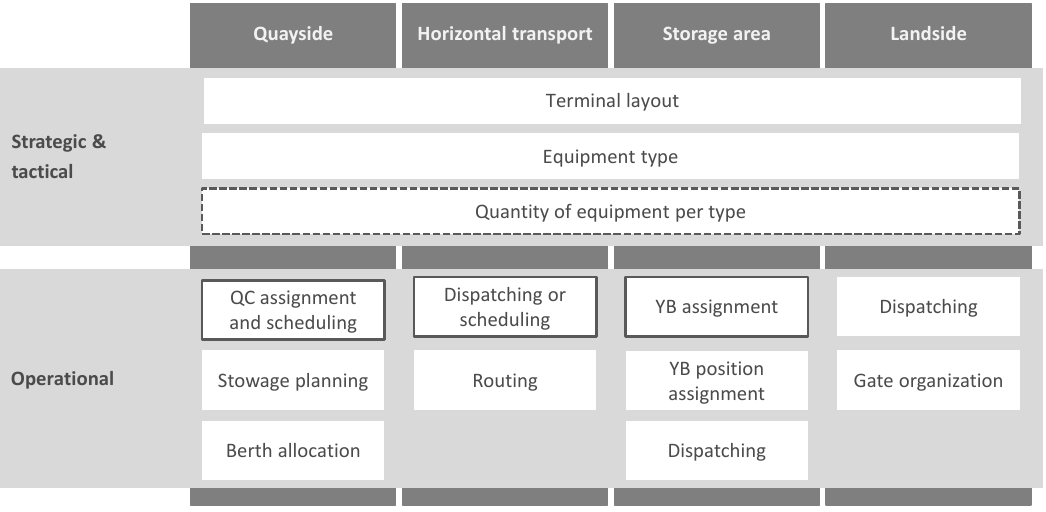
Figure 1. Decision problems at container